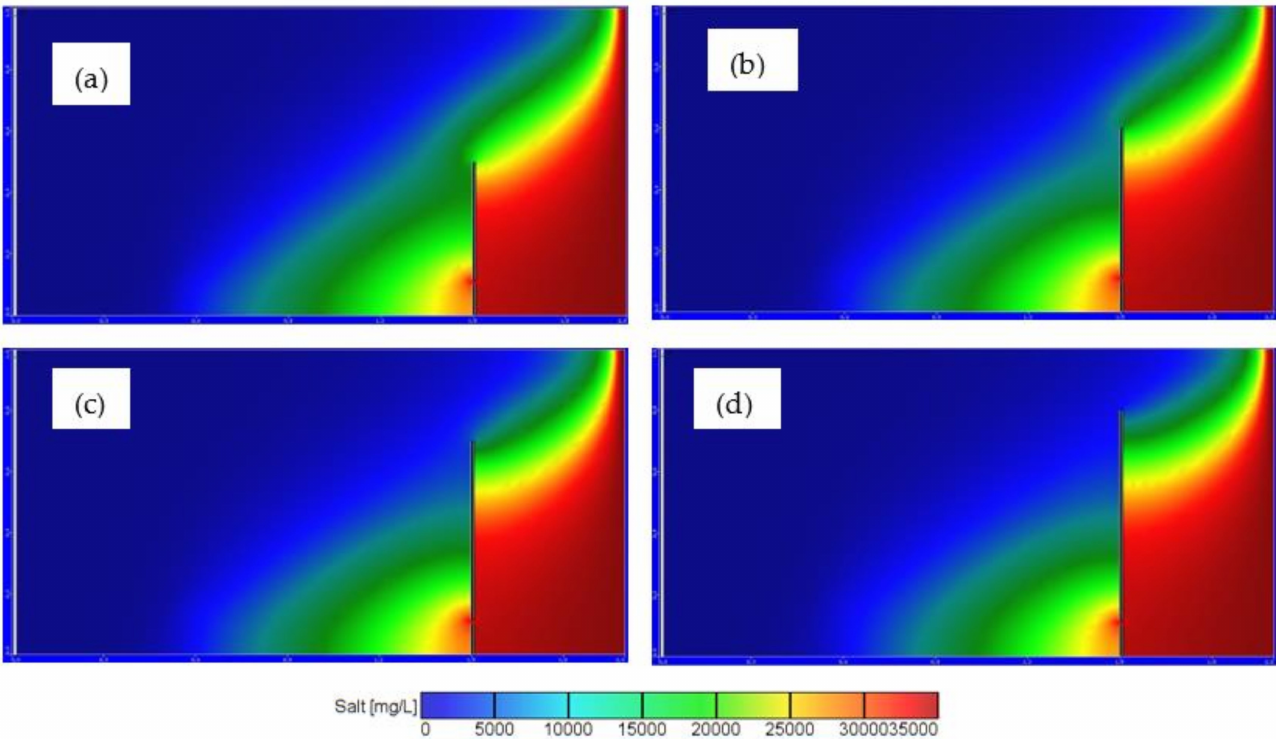
Figure A2. Salinity distribution for D f = 0.01 m, H f = 0.1 m, L d = 0.5 m for different values of